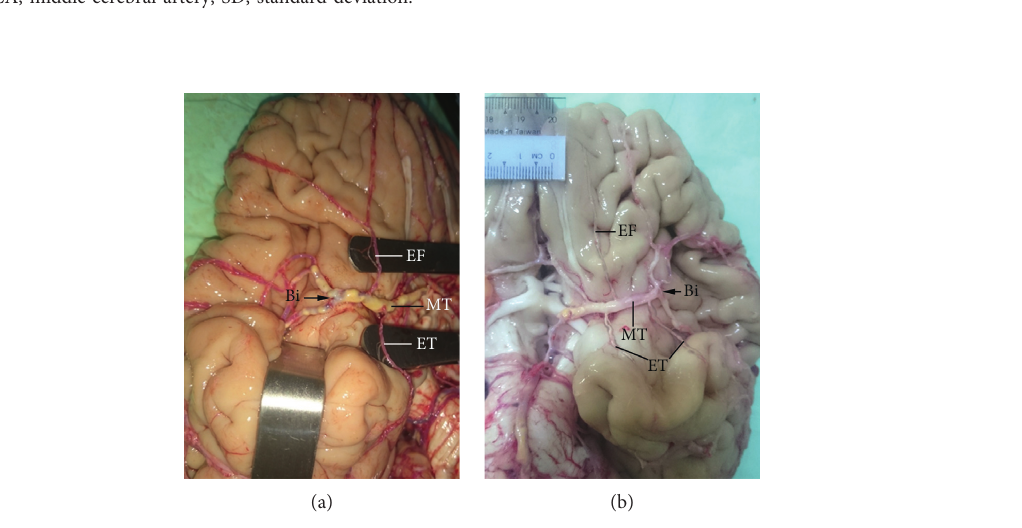
Figure 4: Early cortical branches. (a) Early frontal (EF) and early temporal (ET) branches. (b) Three early cortical branches (1 EF and 2 ET). The MT and bifurcation (Bi) of the MCA are